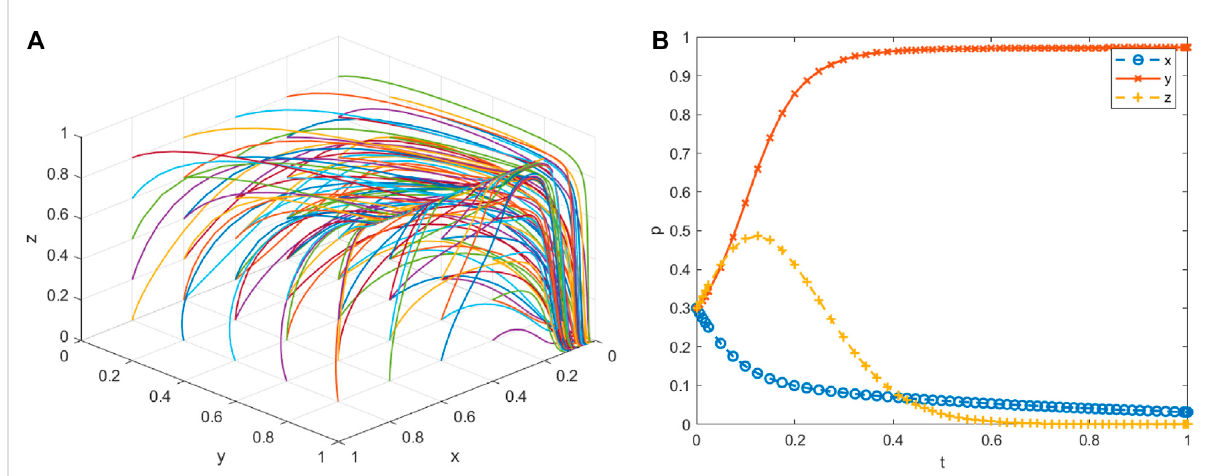
FIGURE 4 Simulation results of Scenario 3 evolution. (A) The three-dimensional phase diagram, which can show the evolution situation more clearly, and (B) The two-dimensional diagram, which can show the sensitivity of the game subject to the income more